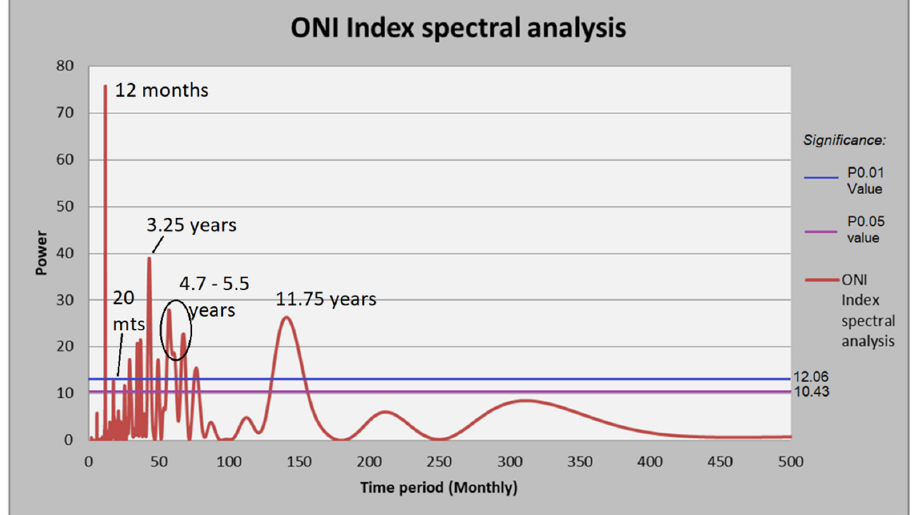
Figure 3. Spectral analysis of the ONI index for the period 1950–2019 on a monthly scale. The red line represents the variability of the spectral power, while the blue line represents the minimum value of significance P0.01 (12.06), and the purple line the minimum value of P0.05 (10.43).